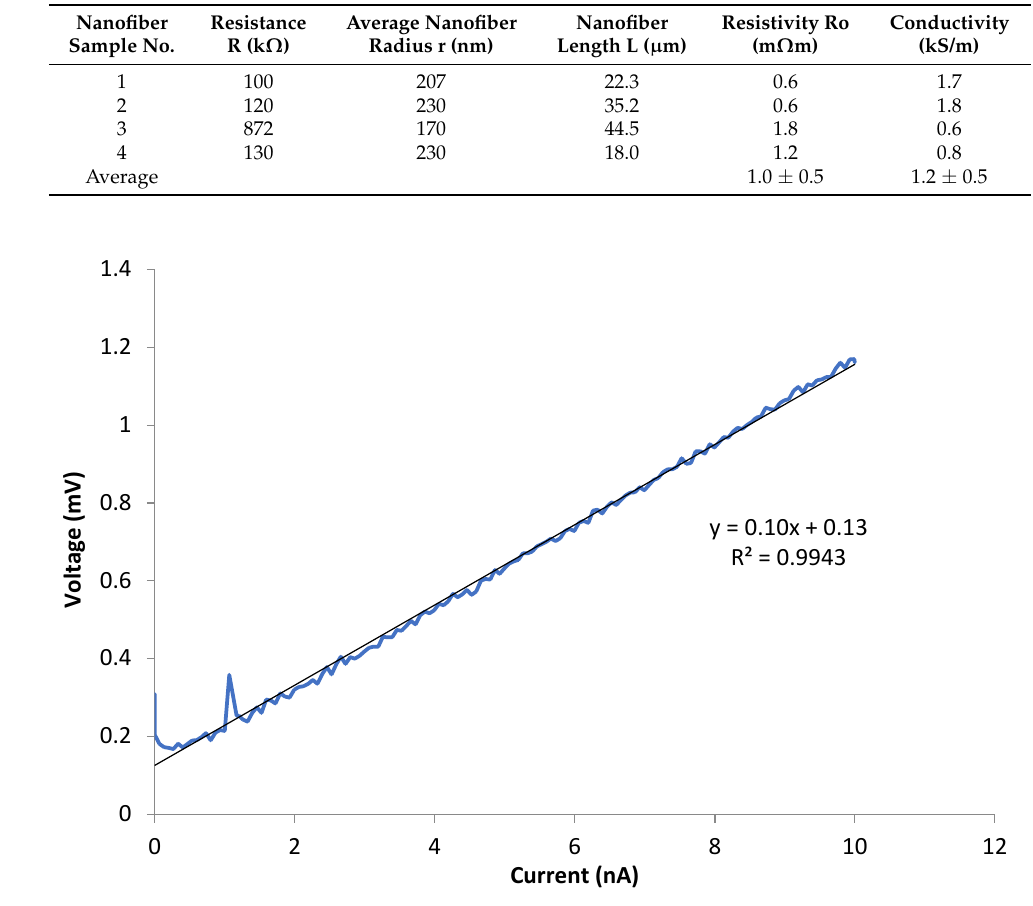
Figure 9. Typical current-voltage (I– V ) curve of single TiON/C - CNF2 exhibiting ohmic-type con- Figure 9. Typical current-voltage (I–V) curve of single TiON/C-CNF2 exhibiting ohmic-type conductivity. ductivity. Sheet resistivity of TiON/C-CNF1 fabric was also measured. For a typical sample, we measured the sheet resistivity of around 630 Ω (cid:3) and nanofiber radius of 130 nm.